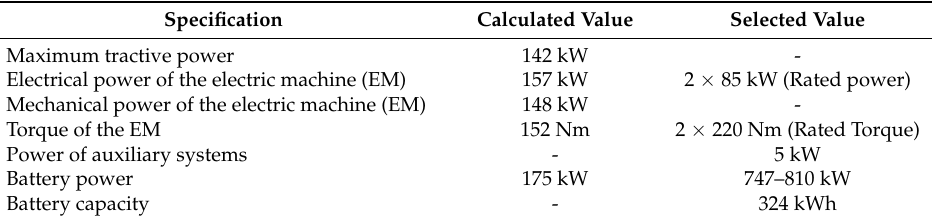
Table 7. Estimated and select values of the